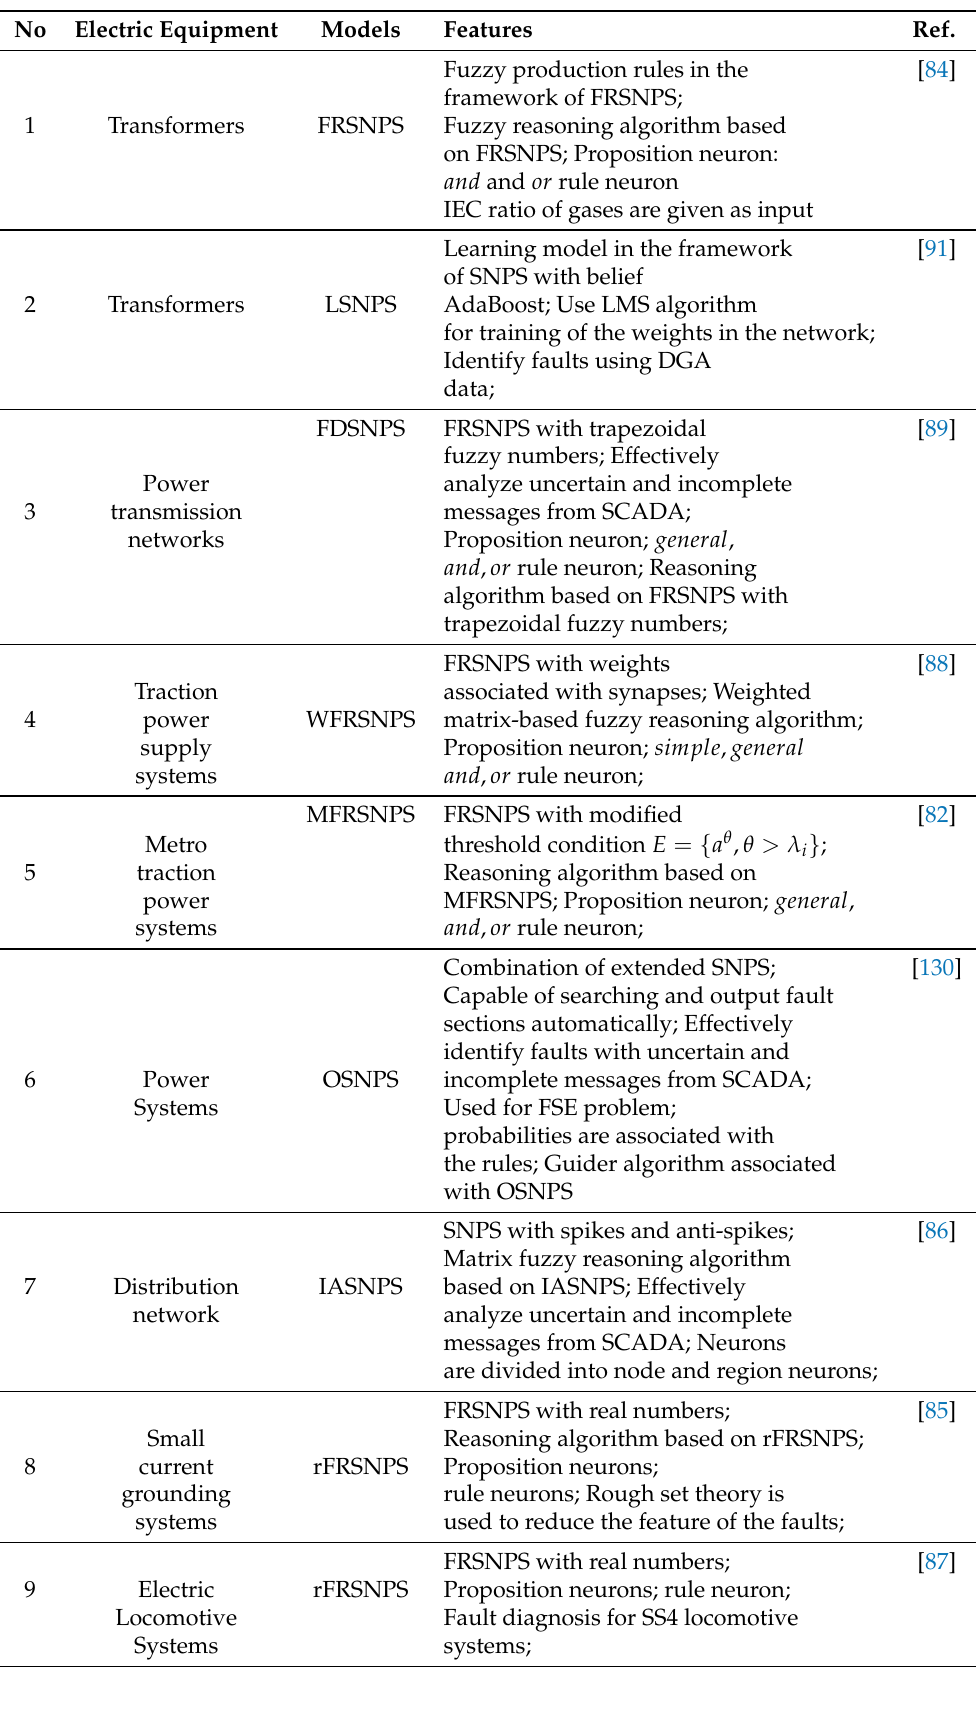
Table 2. Comparisons of fault diagnosis models with spiking neural P